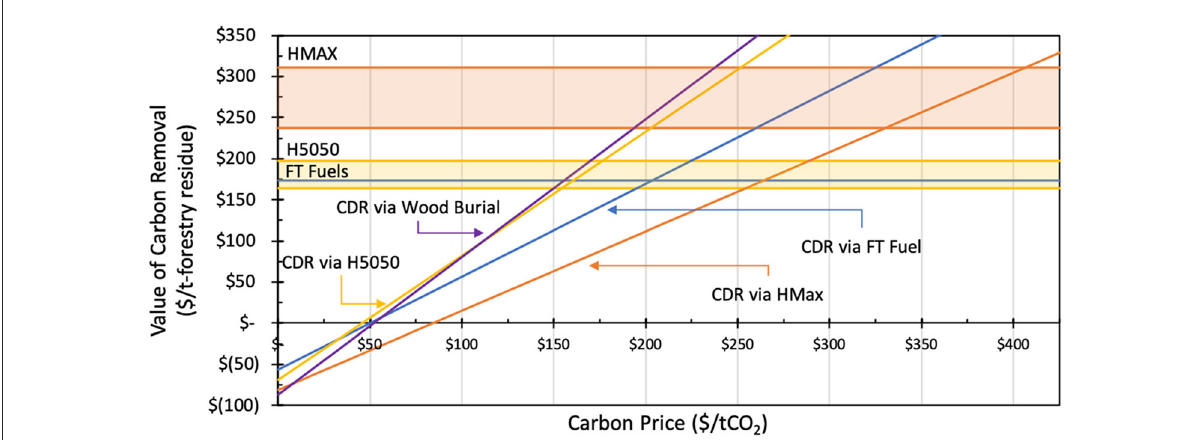
FIGURE3 Comparison of the energy- and carbon-related revenues from gasification of forestry residue. Also shown is the estimated carbon revenue from burying an equivalent amount of forestry residue. A range of liquid hydrogen prices is given, as described in the